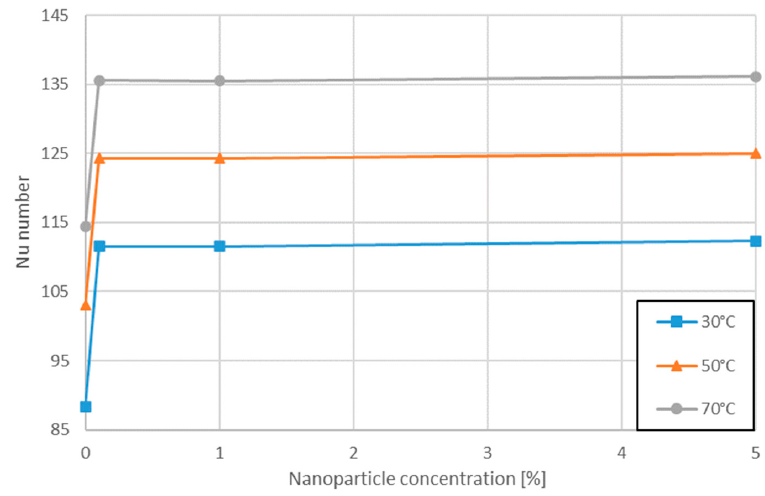
Figure 18. Variation of Nu number for water-Al 2 O 3 nanofluids.